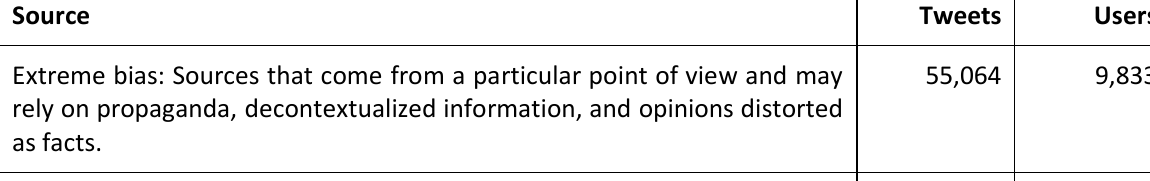
Table 4. Low-credibility, news, and other links shared in the dataset. Explanations of the low-quality labels are included (Zimdars et al., 2017; Zimdars, 2016), along with statistics about each link category. The ‘other’ category includes links to domains that are neither news nor low-quality sources.